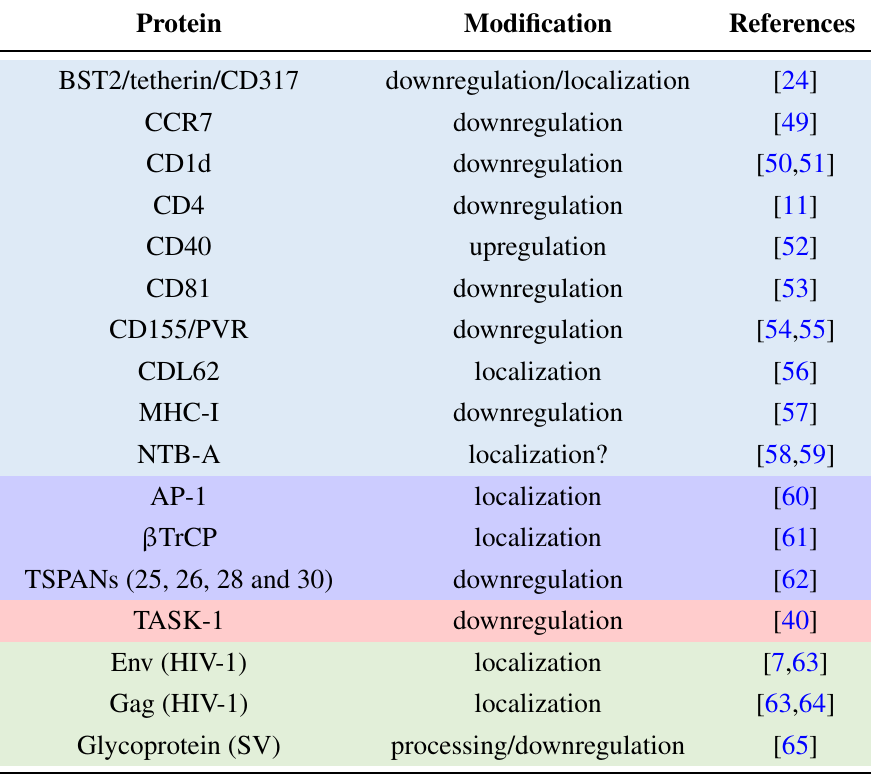
Figure 2. Subcellular localizations of Vpu protein. Vpu modifies the protein transport of newly synthesized proteins. Degradation through the lysosome pathway (illustrated with Bone Marrow Stromal Cell Antigen 2 (BST2)) or the proteasome pathway (illustrated with CD4) are included. β-transducing-repeat-containing protein (βTrCP) or unknown cellular cofactor and also the two possible locations (trans-Golgi network (TGN) and plasma membrane (PM)) where BST2 and Vpu converge and traffic are depicted. Table 1. Proteins modulated by Vpu. Cellular and viral proteins respond to the presence of intracellular Vpu by altering their trafficking or intracellular concentration. The table includes membrane proteins exposed to the cell surface (blue), proteins involved in protein trafficking or virus release (purple), K+ channel (pink) and virus-encoded proteins (green). Protein